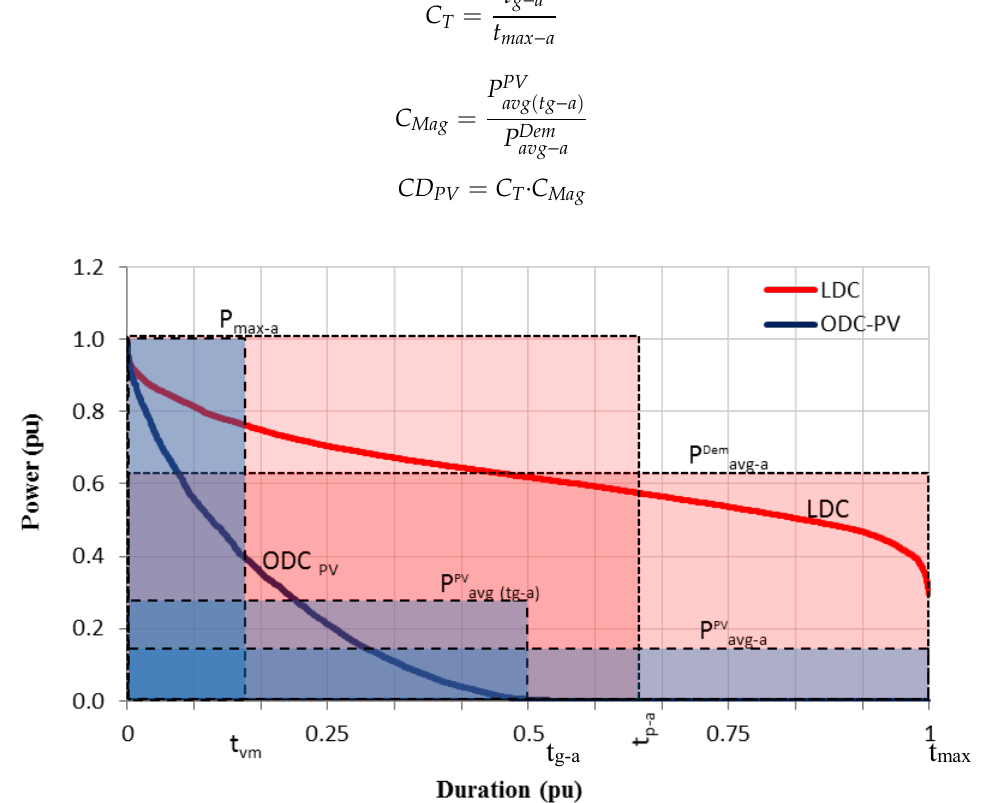
Figure 6. Equivalent rectangular areas for the PV generation (blue) and the demand (red).